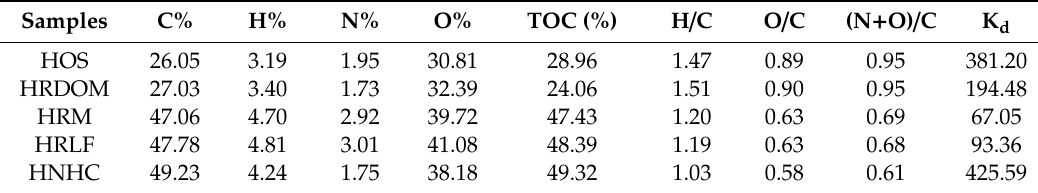
Figure 10. The infrared spectra of different fractions: ( a) before adsorption; ( b) after adsorption. The atomic ratio about H/C, (N+O)/C and O/C indicate the aromatics, polarity, and hydrophilicity of different fractions, respectively (Table 8). Table 8. Elemental composition of different humus fractions.